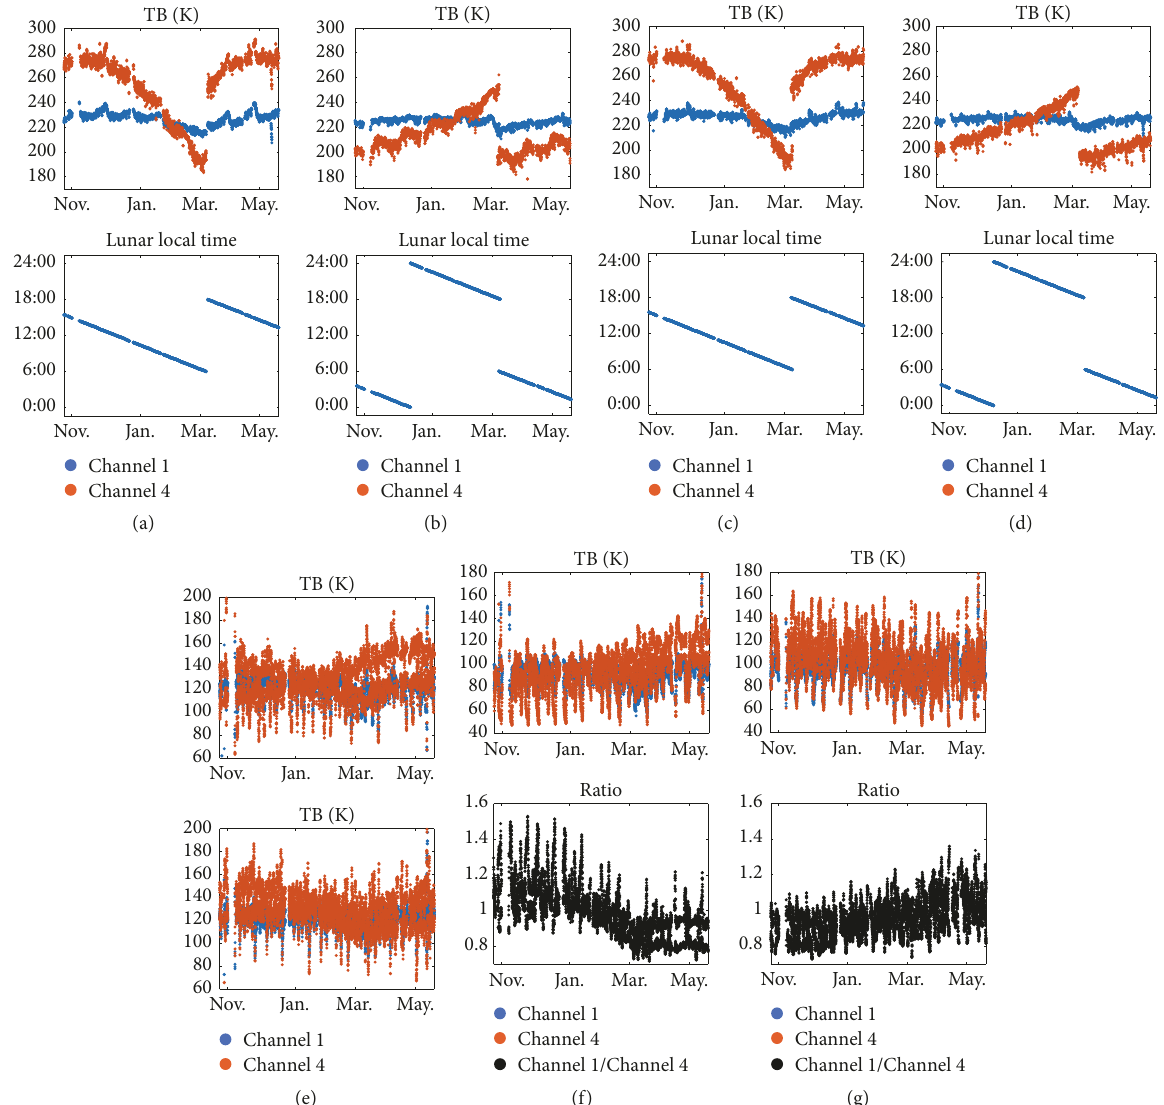
Figure 1: The data shown in (a)–(g) is selected in the latitude zones 20 ∘ N/S, 80 ∘ N/S, and 85 ∘ N/S, respectively. The upper part of (a)–(d) represents the fact that the TB of channel1 and channel 4 varies during the whole observation period in daytime and nighttime at latitude 20 ∘ N ((a); (b)) and 20 ∘ S ((c); (d)), respectively. The bottom part of (a)–(d) shows the changes of lunar local time converted from “hour angle” of the corresponding TB data. Lunar local time varies with date nearly uniformly, so data diagram represents the TB variations in a half lunation cycle. The data shown in (e) represents the TB variations of channel 1 and channel 4 at 80 ∘ N and 80 ∘ S from top to bottom. The variations of TB and TB ratio between channel 1 and channel 4 are shown in (f) and (g) at 85 ∘ N (f) and 85 ∘ S (g) from top to bottom.